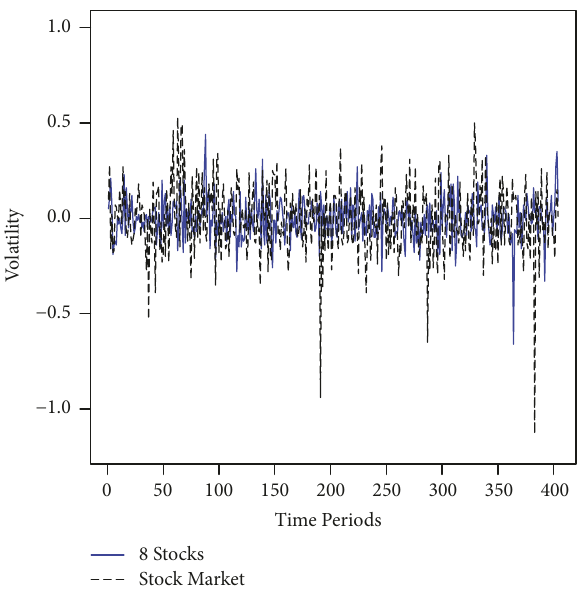
Figure 1: Volatility from the entire stock market and from the 8 selected stocks for 400 time periods.